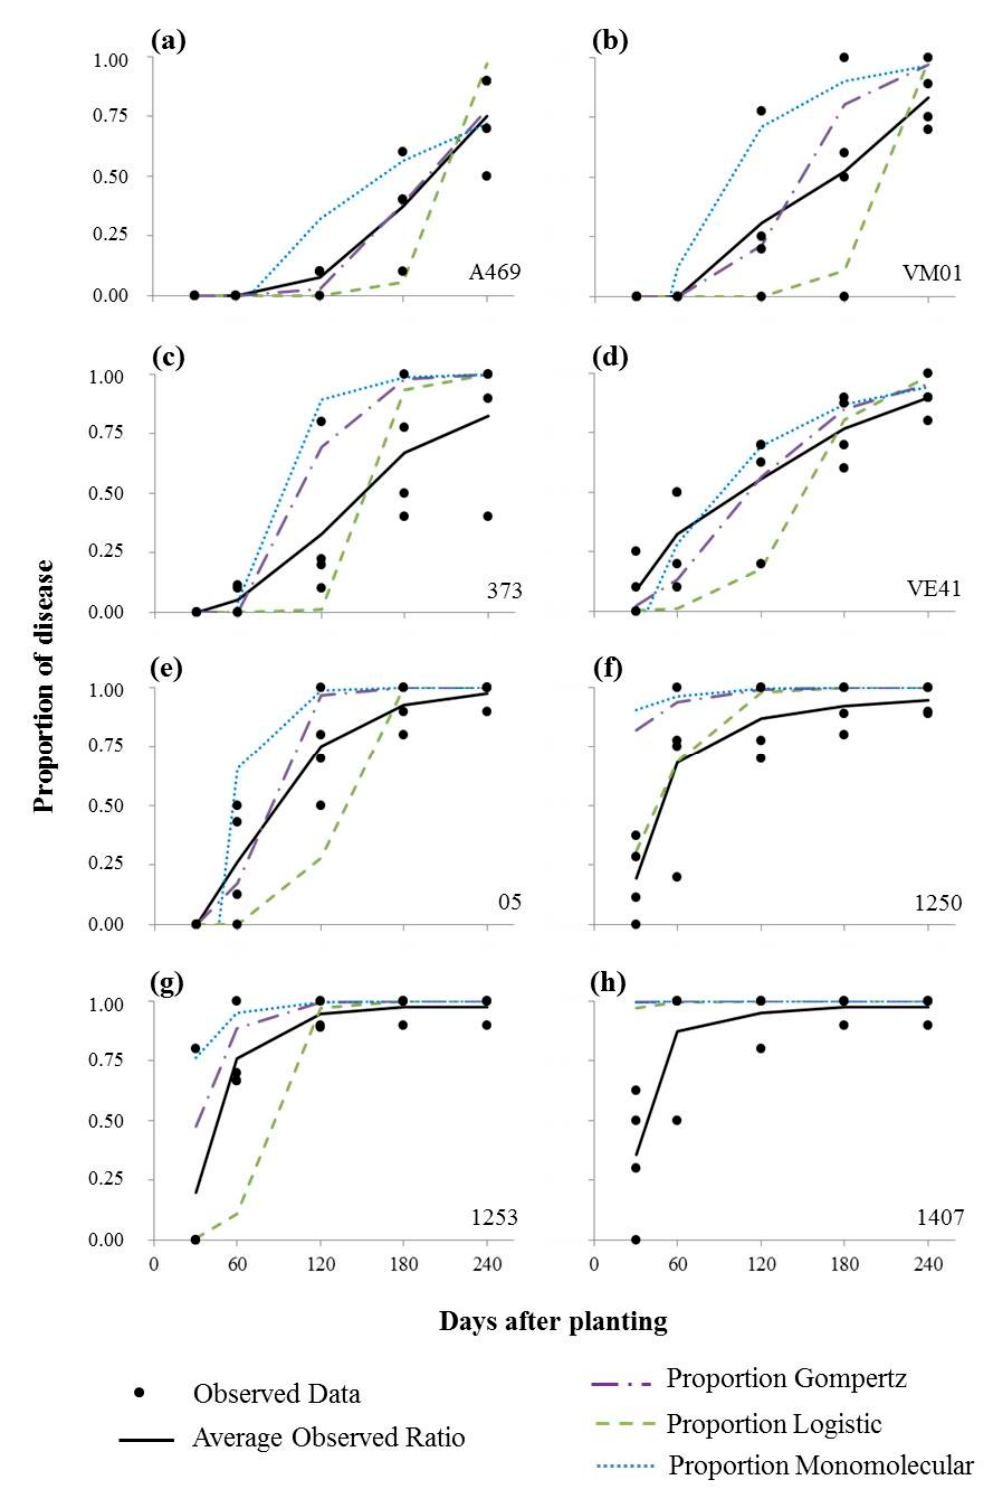
Figure 1. Bacterial leaf blight incidence as a function of time in different eucalyptus clones. Comparison between observed data and disease progress curves obtained by observed means and those obtained by applying the Logistic, Gompertz, and Monomolecular models. ( a ) Clone A49; ( b ) Clone VM01; ( c ) Clone 373; ( d ) Clone VE41; ( e ) Clone 05; ( f ) Clone 1250; ( g ) Clone 1253; ( h ) Clone 1407.